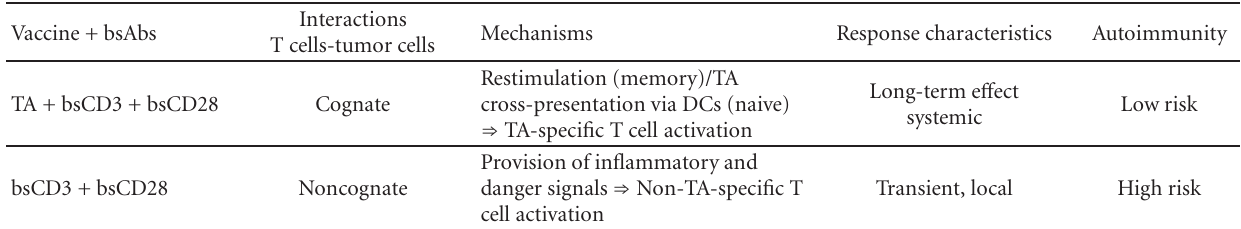
Table 1: Summary of the types of interactions, mechanisms,characteristics of the immune responses induced by the ATV-NDV/bsAb vaccine in memory and naive T cells and the eventual danger of autoimmunity (see the main text for more